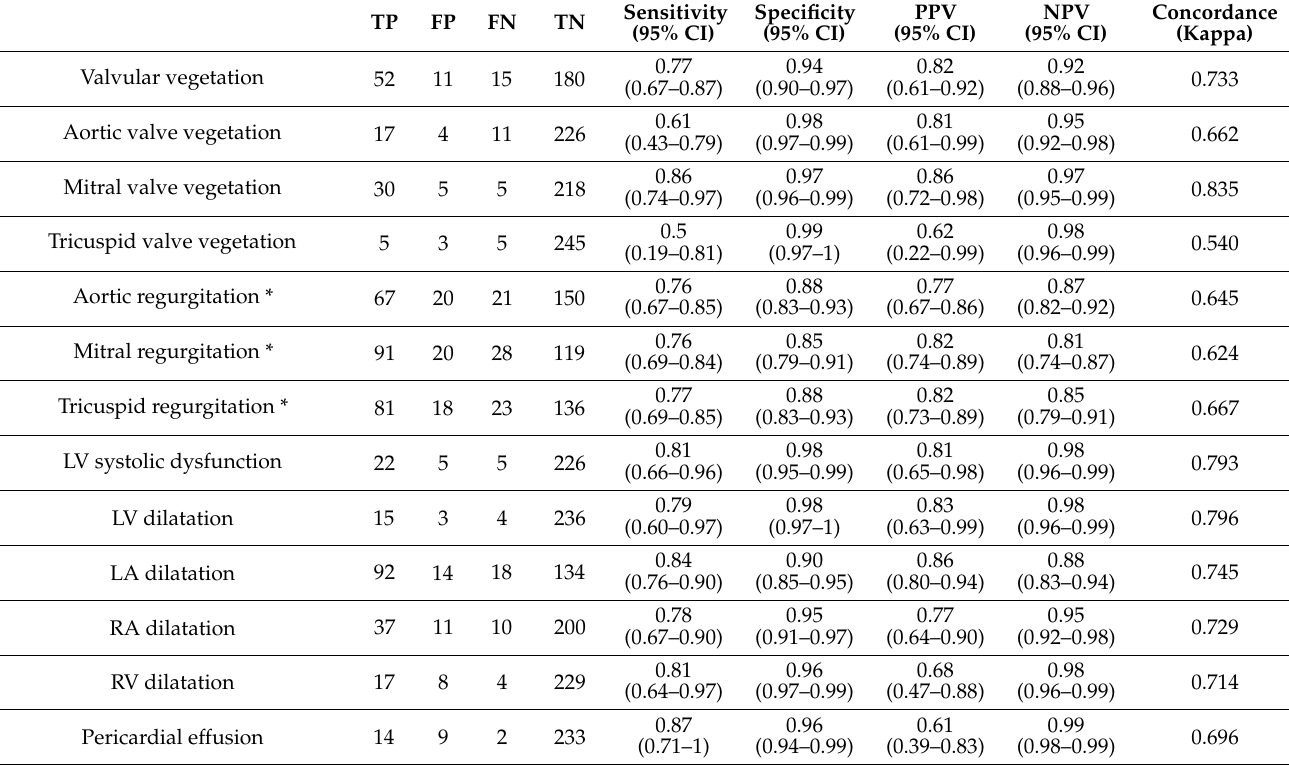
Table 5. Usefulness of POCUS for the detection of signs suggestive of IE in patients with bacteremia or